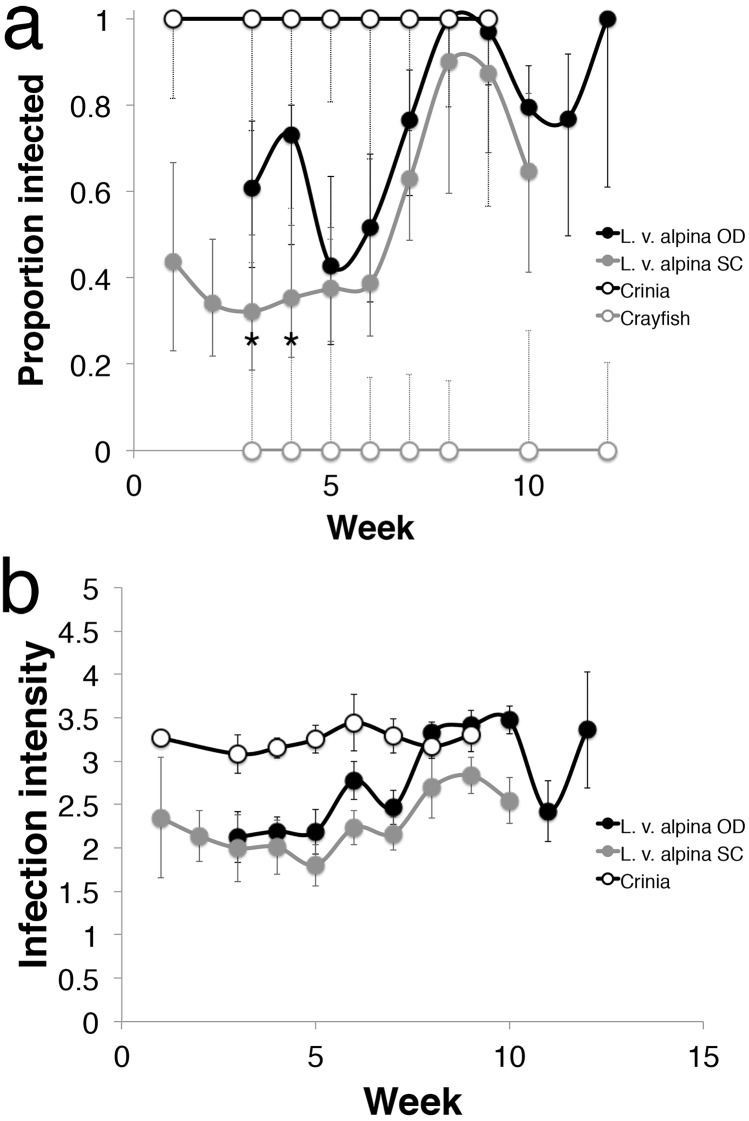
Infection prevalence and intensity across sites for Litoria verreauxii alpina, Crinia signifera and Cherax destructor.(a) Prevalence of infection. Error bars indicate 95% confidence intervals. (*) indicates time-points where prevalence is significantly different at each site for Litoria verreauxii alpina, using Pearson’s Chi-Squared test. (b) Infection intensity transformed to log10 scale. Error bars indicate standard error. Sites are Oglives Dam (OD) and Sponar’s Creek (SC).